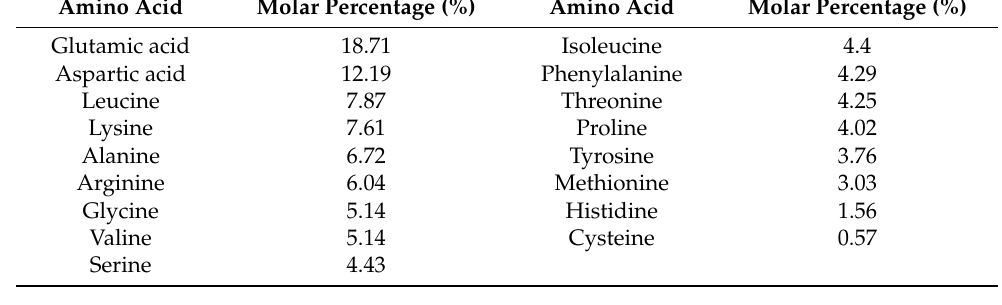
Table 1. Amino acid compositions of antifreeze peptides from defatted Antarctic krill (AKAPs). Amino Acid Molar Percentage (%)